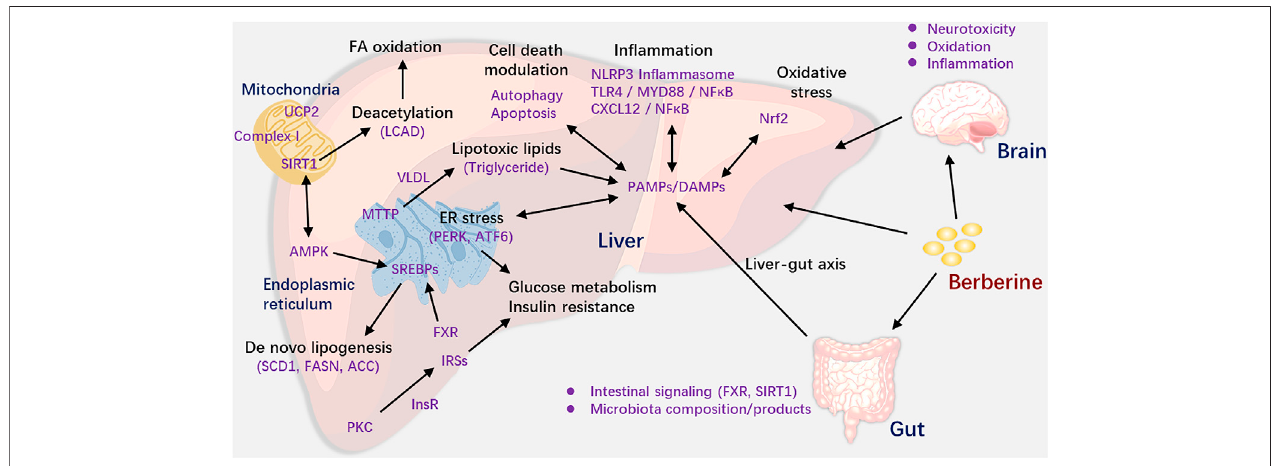
FIGURE 4 | Role and mechanisms of BBR in treating